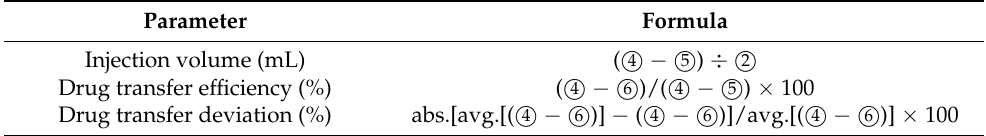
Table 3. Equations for injection volume, transfer efficiency, and deviation measurement.